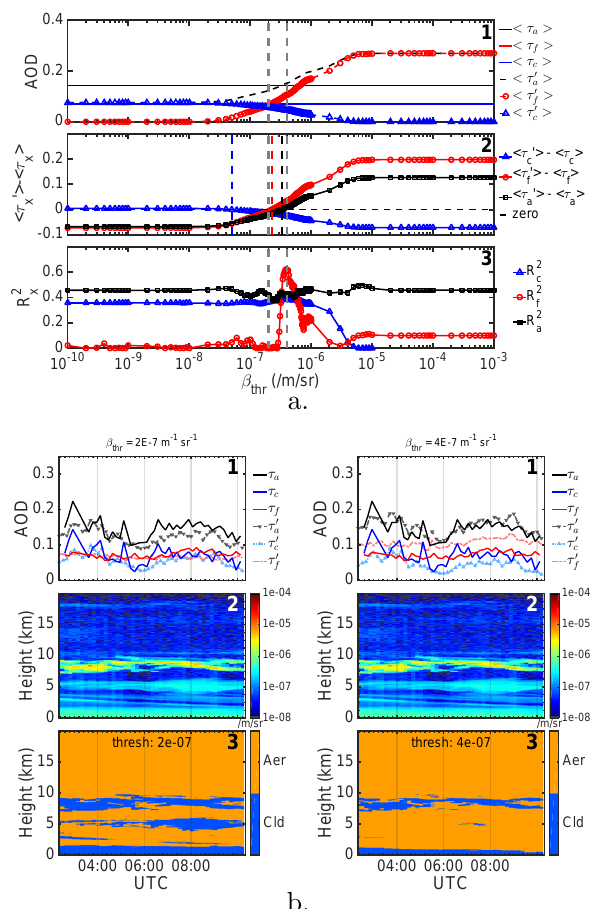
Figure 2. Backscatter threshold sensitivity ( β thr ) study for the 9 March 2011 Eureka aerosol event. (a) Top graph: event-averaged lidar and star photometer AODs as a function of the cloud discrim- ination threshold β thr . Middle graph: differences between star pho- tometry and lidar event-averaged AODs. The vertical dotted lines (cid:105) , (cid:104) τ c (cid:105) = (cid:104) τ (cid:48) (cid:105) and (cid:104) τ (cid:48) (cid:105) = indicate values of β thr for which (cid:104) τ f (cid:105) = (cid:104) τ (cid:48) c a f (cid:104) τ (cid:48) (cid:105) respectively. Bottom graph: coefficients of determination be- a tween the lidar and star photometry optical depths across the dura- tion of the event. The two vertical grey lines indicate β thr thresholds used in (b) ; (b) panes 1: star photometry and lidar fine mode, coarse mode and total AODs (500nm) corresponding to the β thr values in- dicated above the panes; panes 2: CRL 532nm backscatter cross- section for the two β thr values; panes 3: cloud/aerosol classification for the two β thr